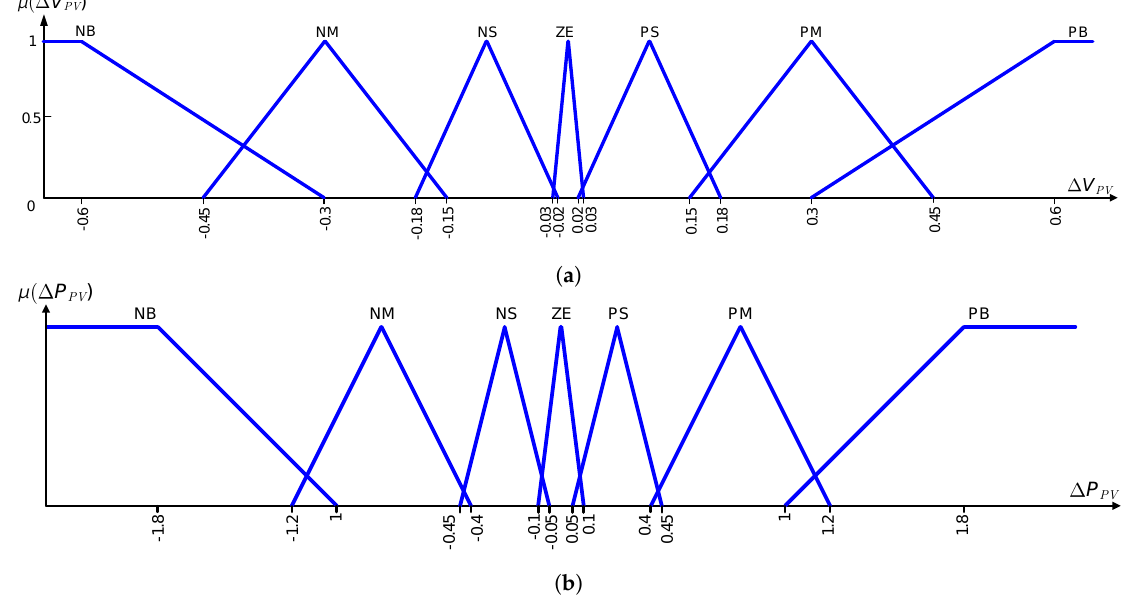
Figure 9. ( a ) Membership function input variable ∆ V PV ; ( b ) Membership function input variable ∆ P PV . NB, Negative Big; NM, Negative Moderate; NS, Negative Small; ZE, Zero; PS, Positive Small; PM, Positive Moderate; PB, Positive